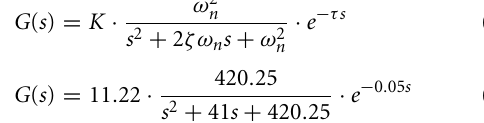
FIGURE 6 | (A) Magnitude plot and (B) phase